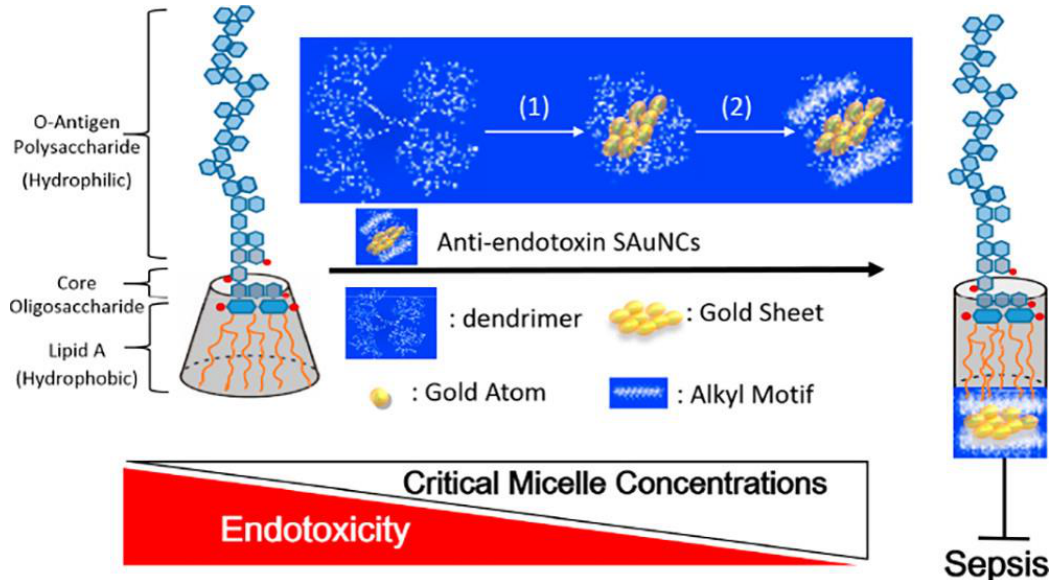
Figure 9. Illustration of interaction between SAuNCs, lipid A of LPS and sepsis progression. Figure9. IllustrationofinteractionbetweenSAuNCs, lipidAofLPSandsepsisprogression. Reproduced Reproduced with permission from Reference [82]. Copyright © 2018, American Chemical Society. with permission from Reference [82]. Copyright © 2018, American Chemical